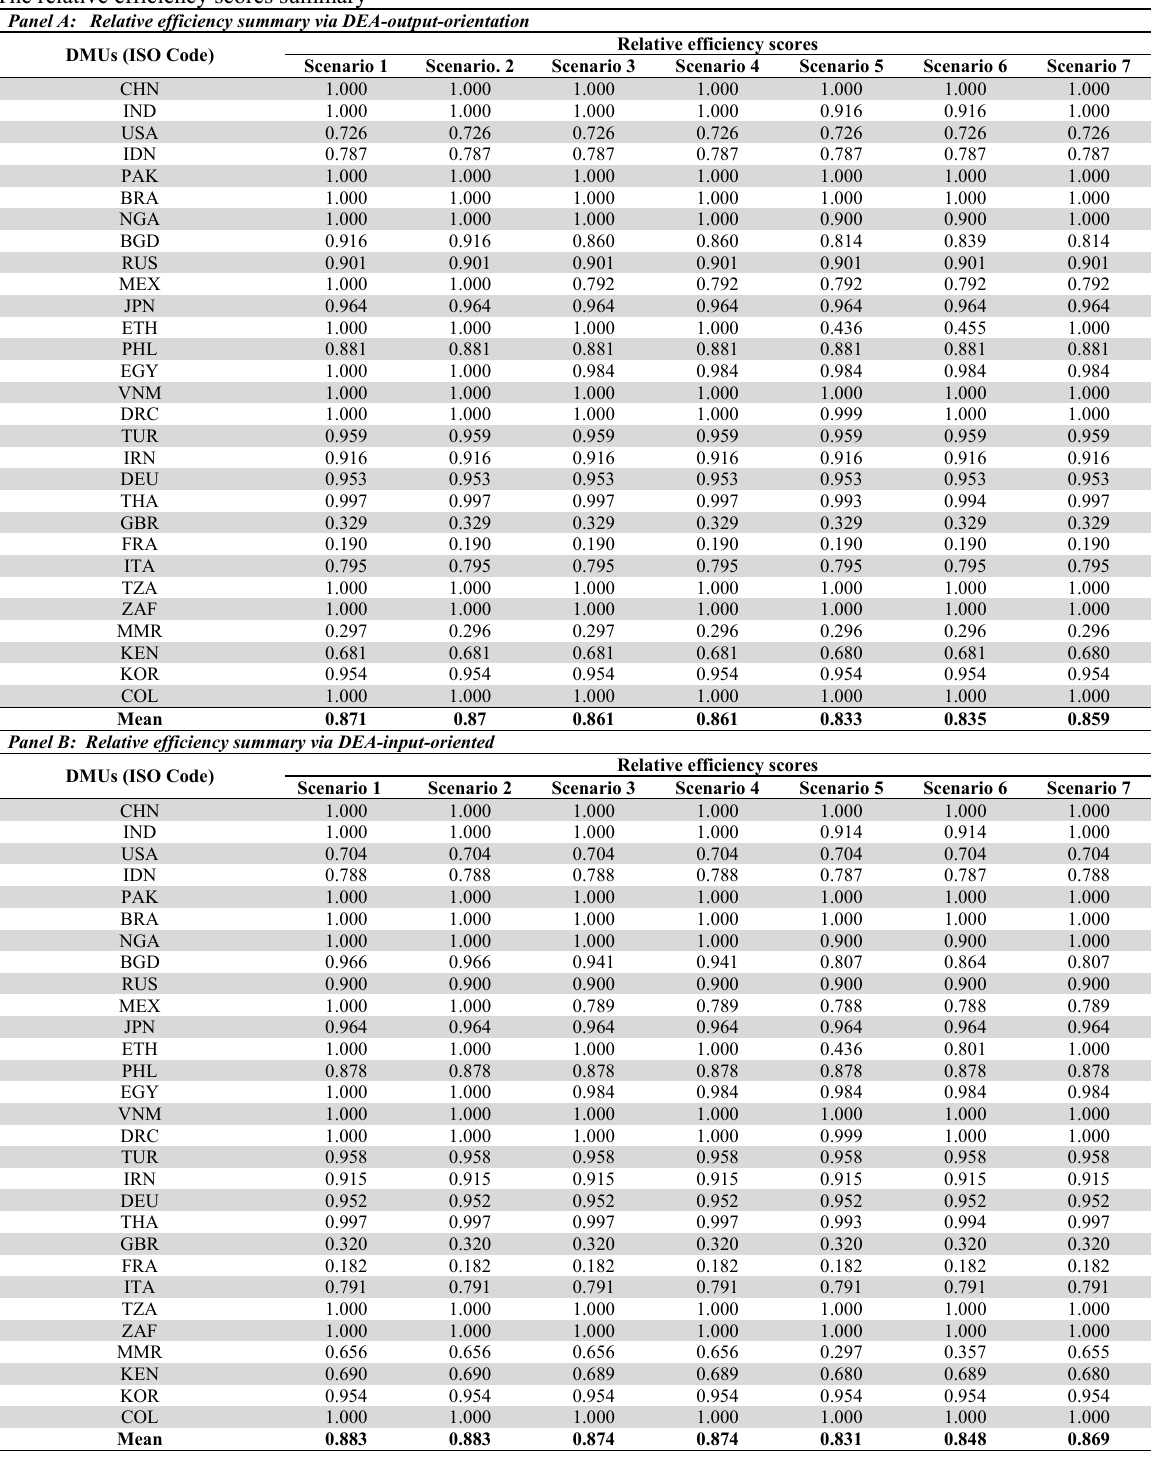
The relative efficiency scores